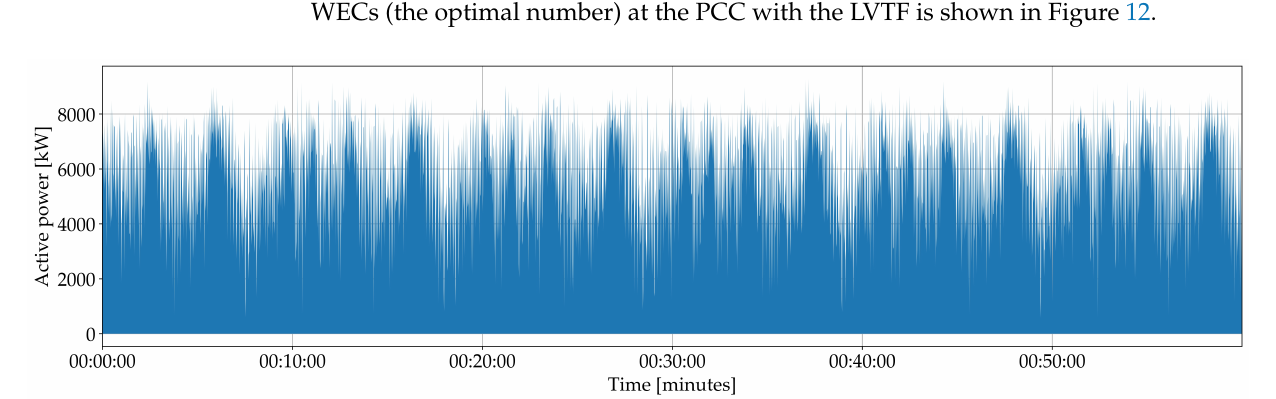
Figure 12. One-hour output power of WPF consisting of 2 WECs at the point of common coupling (PCC) with